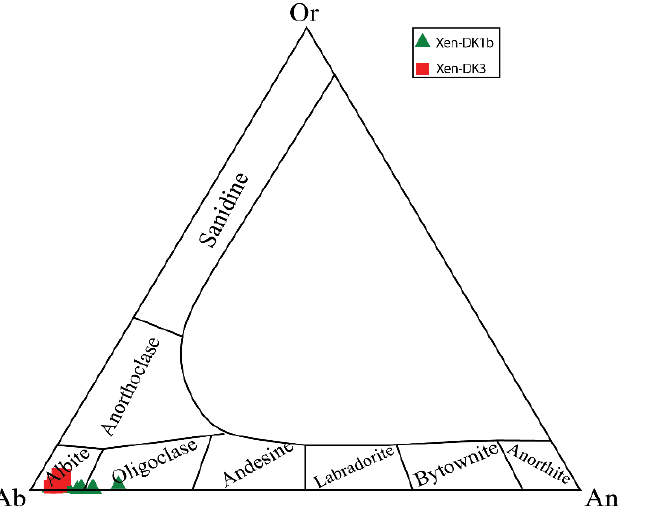
Figure 5. Plagioclase phenocryst compositions for each of the diorite and microdiorite enclaves [19].